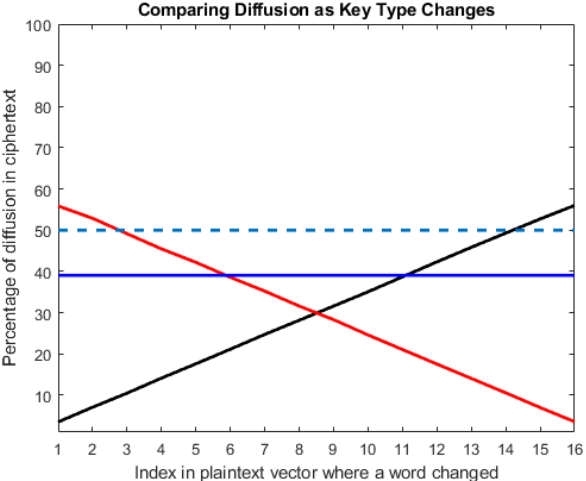
Figure 12. Average percentage of diffusion for different encryption key orientations taken from 1000